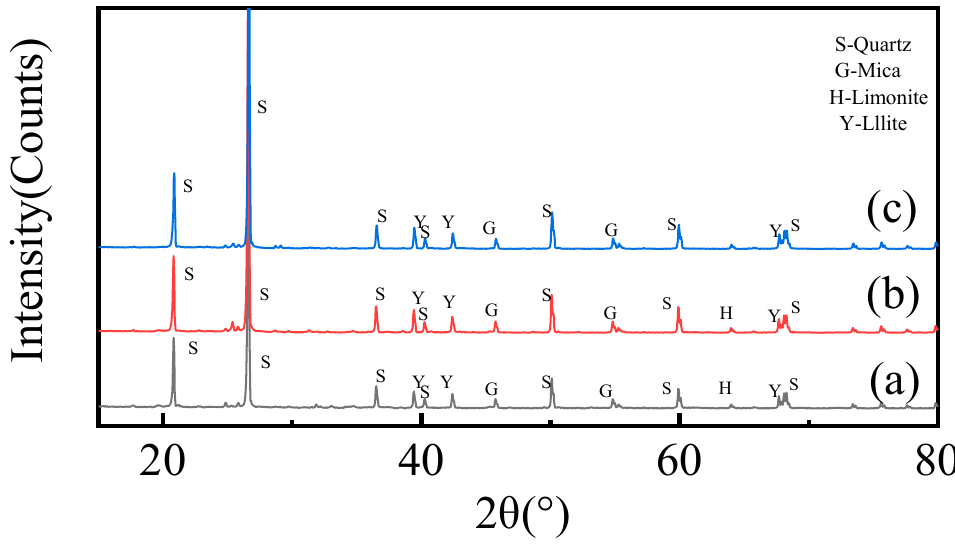
Figure 7. XRD spectrum: ( a ) original samples; ( b ) non-enhanced acid-leaching residues; and ( c ) enhanced acid-leaching